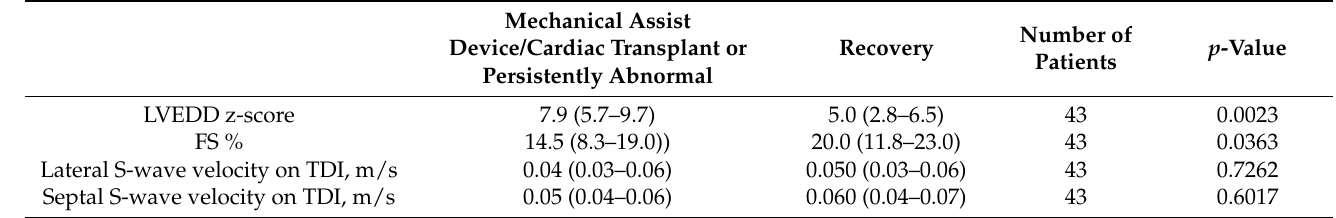
Table 2. Echocardiographic data for LV dimensions and systolic function. Data are presented as median and interquartile range (IQR).